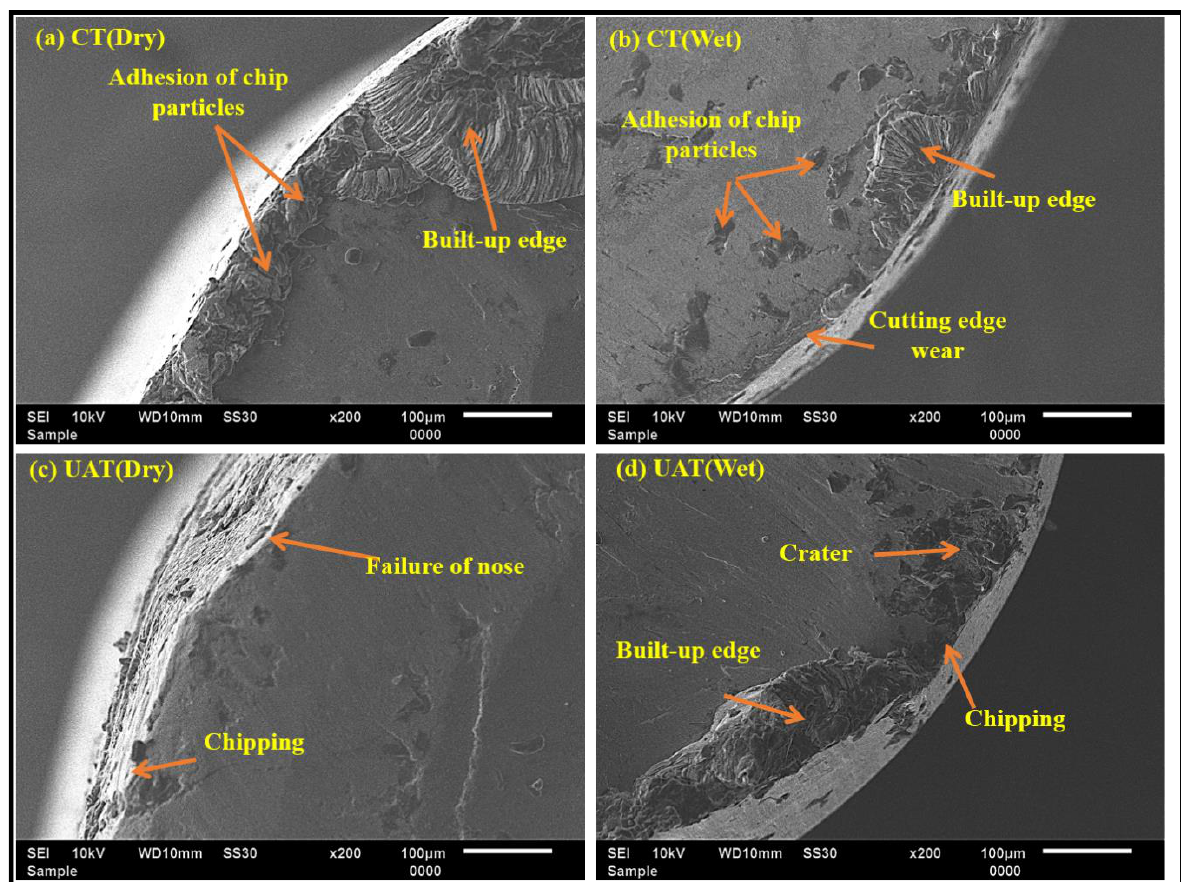
Figure 8. The behaviour of wear on the rake face observed by scanning electron microscope ( 𝑉 = 50 m/min, 𝑓 = 0.2 mm/rev, 𝑎 = 0.4 mm).